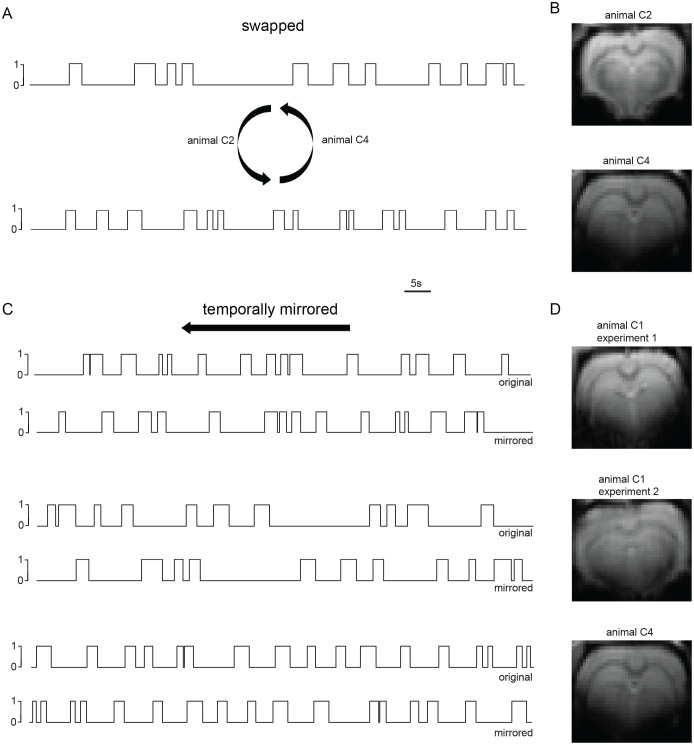
Slow wave BOLD correlates depend on precise slow calcium wave dynamics detected in individual experiments.(A, B) Swapping of slow wave vectors between two animals (A) reveals no BOLD activity upon FIR-based event-related fMRI analysis (B). (C, D) Temporally mirroring slow wave vectors within the same experiment (C) again reveals no activation (D).